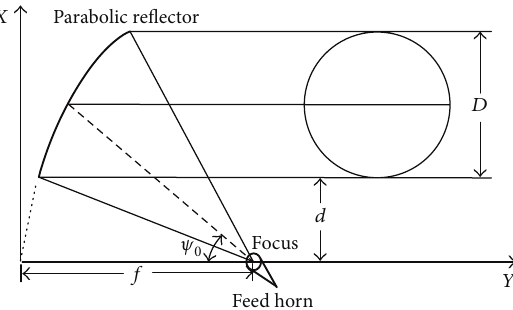
Figure 4: Geometry of the offset parabolic antenna designed for radiometric